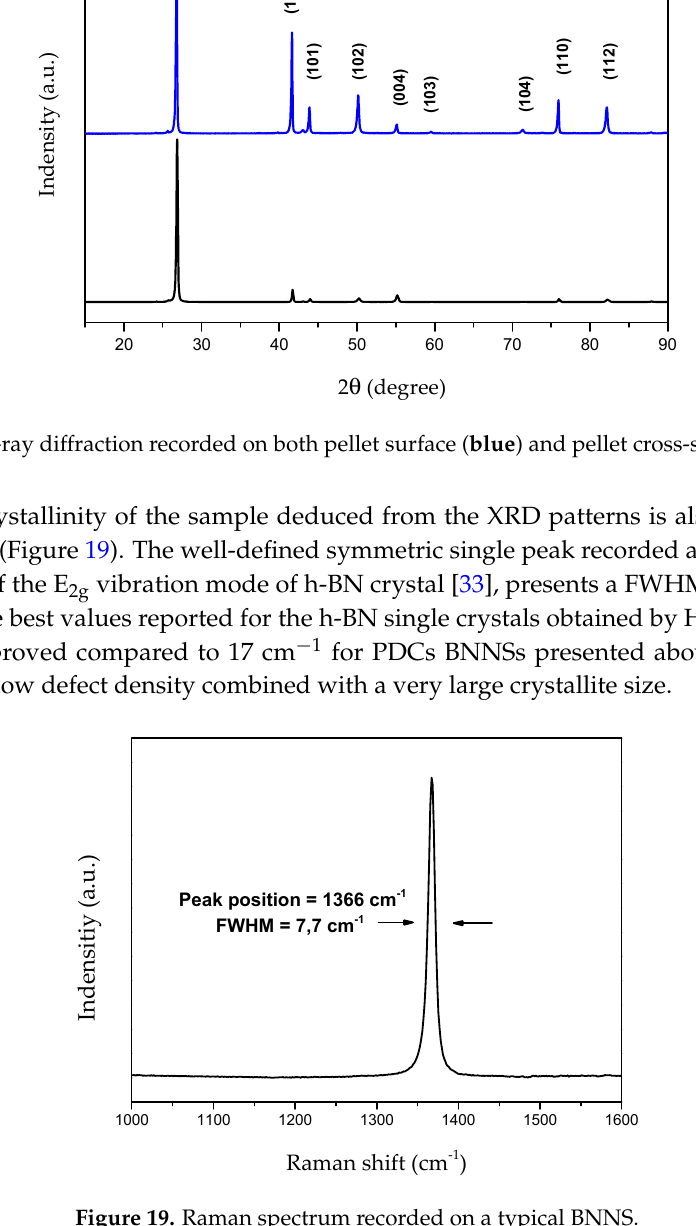
Figure 19. Raman spectrum recorded on a typical BNNS.